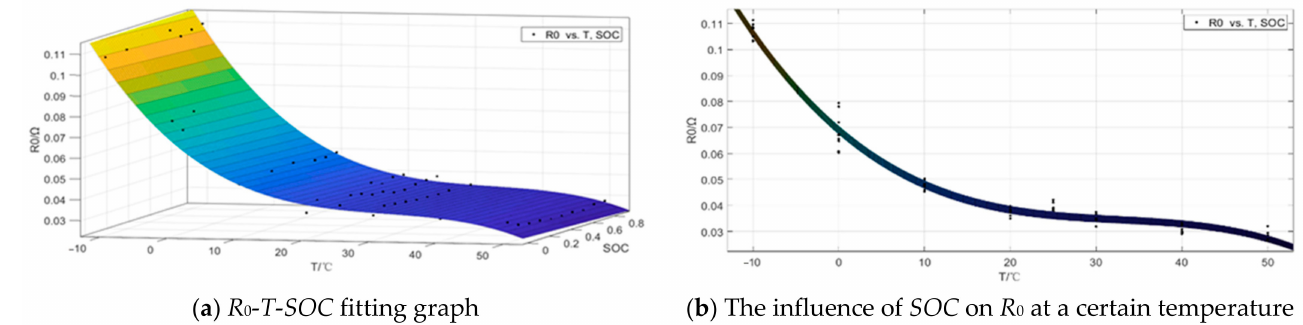
Figure 5. Variation of ohmic internal resistance R 0 with temperature and SOC